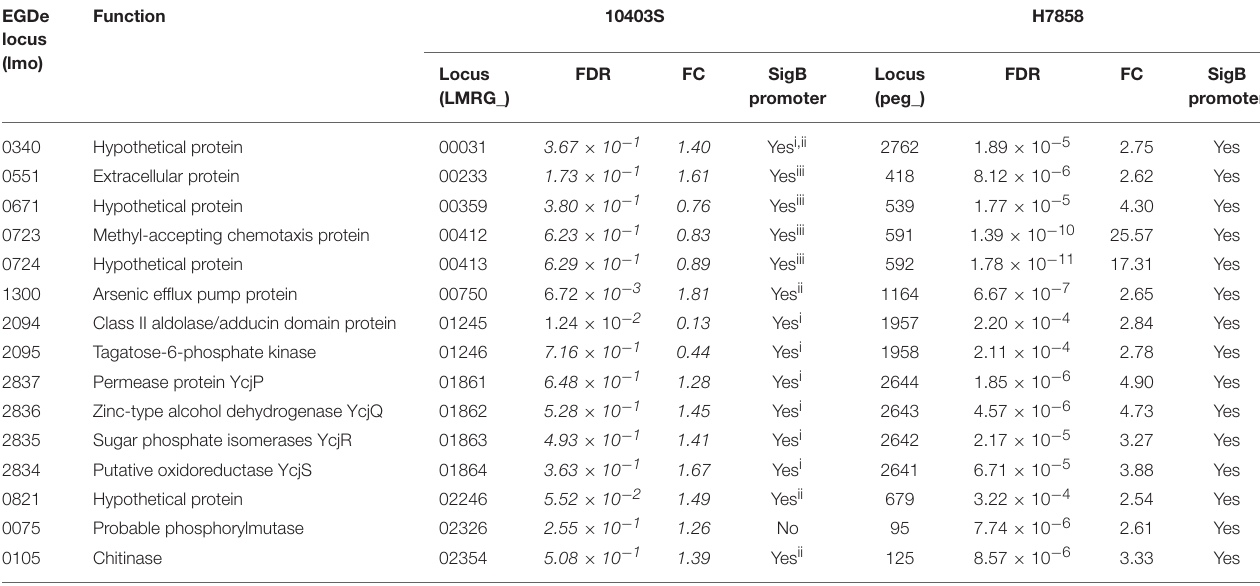
TABLE 6 | Newly identified SigB-dependent genes present in both 10403S and H7858. EGDe locus (lmo)